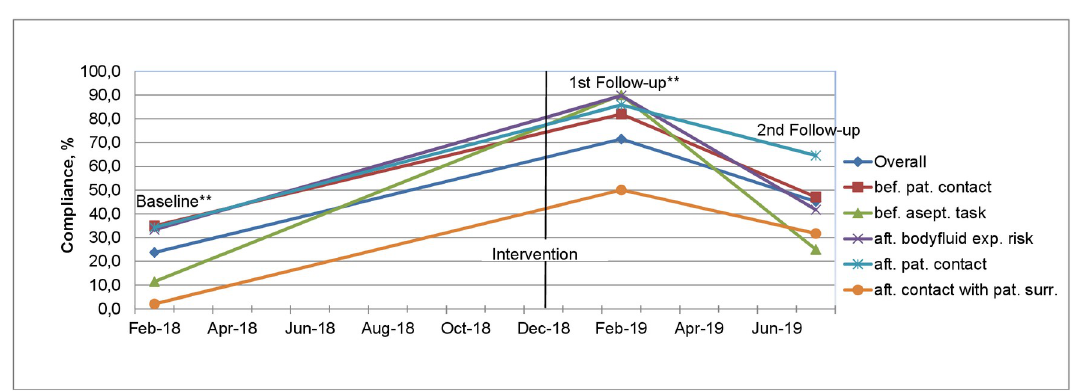
Fig 1. Hand hygiene compliance at baseline, 1 st and 2 nd follow-up, overall and by indication. �� Baseline and 1 st follow-up data from previous publication [13].